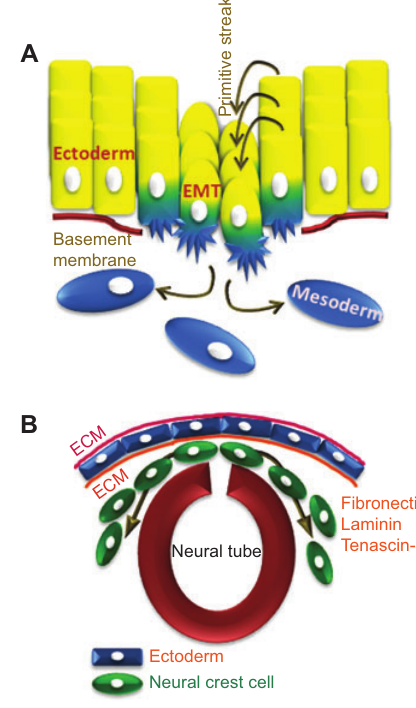
Figure 1 Embryonic EMT. (A) EMT during vertebrate gastrulation. Ectodermal cells undergo- ing EMT ingress through the primitive streak and form mesenchymal cells, which migrate into the underlying tissue becoming the primary mesoderm. (B) Delamination of neural crest cells from the dorsal neural tube. The neural crest cells are formed from an EMT of ecto- dermal cells during the closure of the neural tube. After invading the underlying tissue, neural crest cells migrate throughout the develop- ing embryo giving rise to diverse